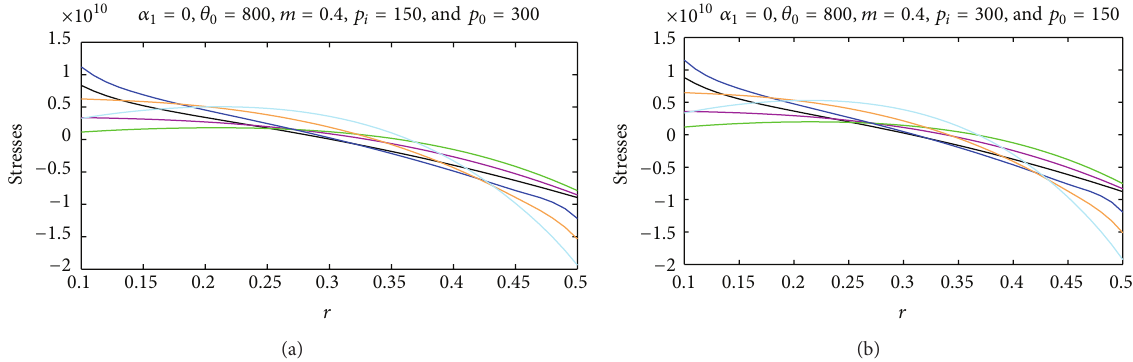
Figure 4: Elastic-plastic stresses in a rotating cylinder with constant thickness and constant density with thermal effects ( 𝜃 0 = 800 ) with parameters 𝑒 1 = 0, 1, 2 and strain hardening measure 𝑚 = 0.4 under internal and external